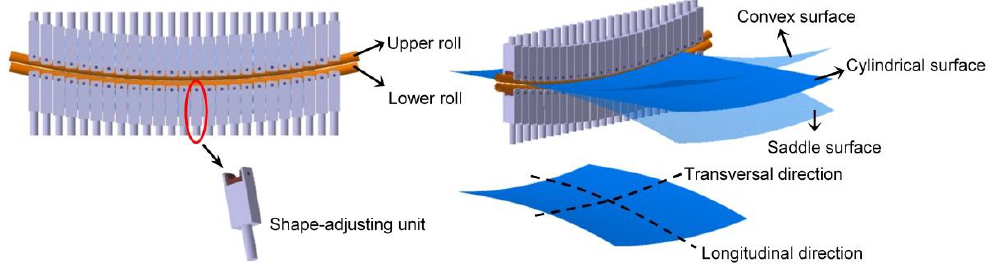
Figure 1. Schematic diagram of continuous roll forming.